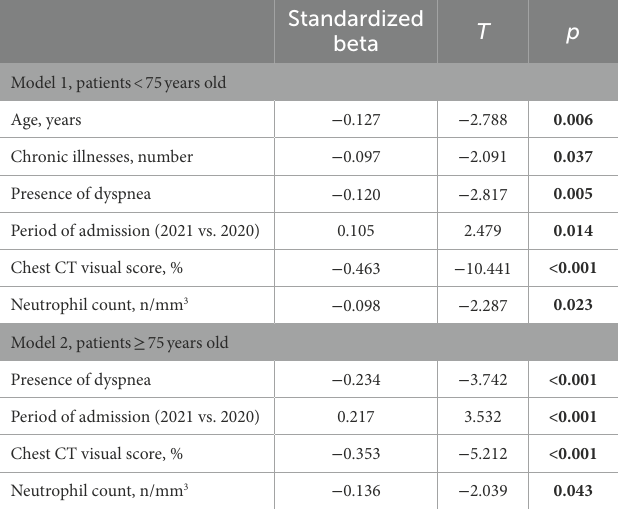
TABLE 4 Stepwise multivariate linear regression models exploring factors independently associated with P/F values in each age class in the studied population of patients from the first and third pandemic